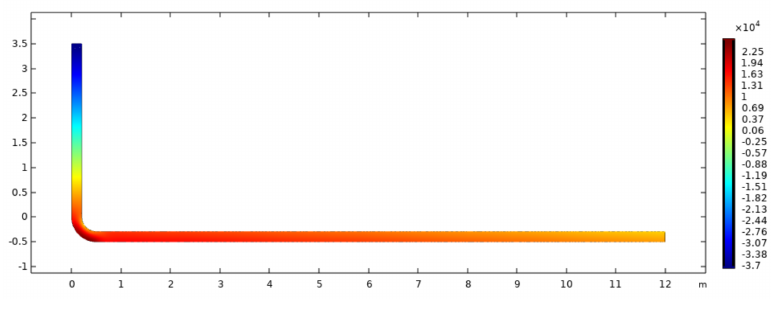
Figure 5. Pressure